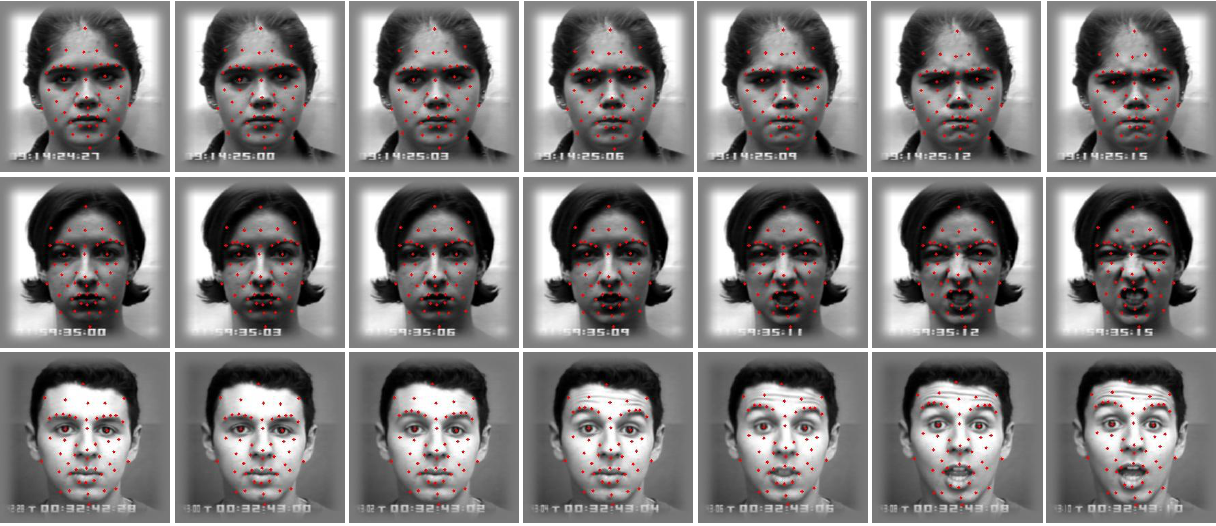
Figure 2. Examples of the result of facial landmark